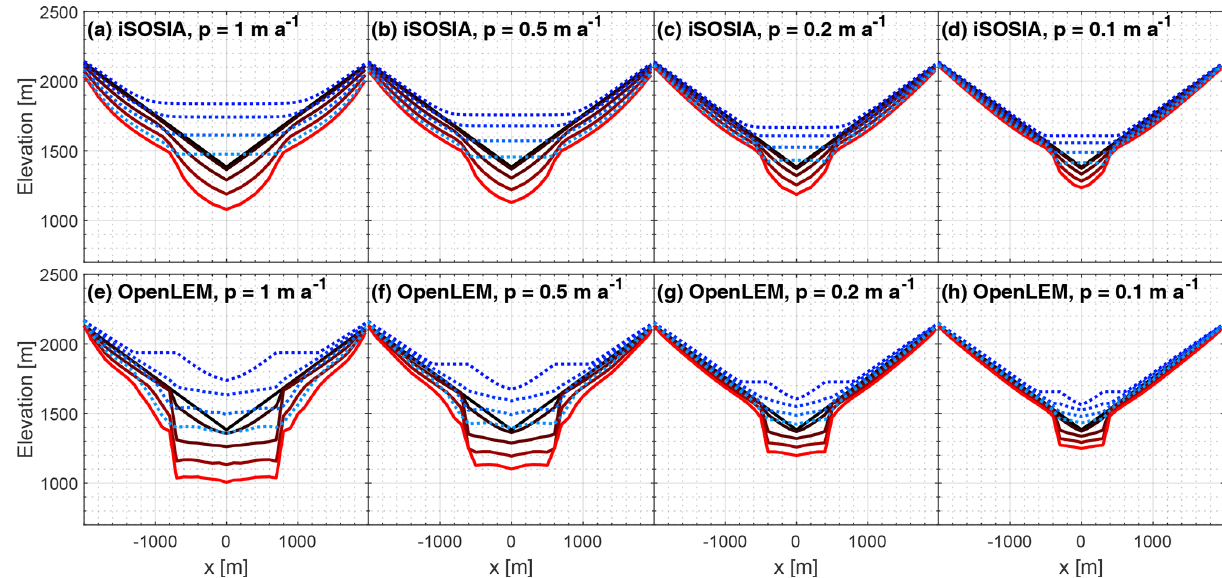
Figure 13. Evolution of cross sections as a function of precipitation rate ( p = 1, 0.5, 0.2 and 0.1) for (a–d) iSOSIA and (e–h) OpenLEM. The black line is the initial profile. The four red lines are after 5, 25, 50 and 75ka. The lines turn from black to red with time. The ice surfaces are shown for the same time steps as dashed blue